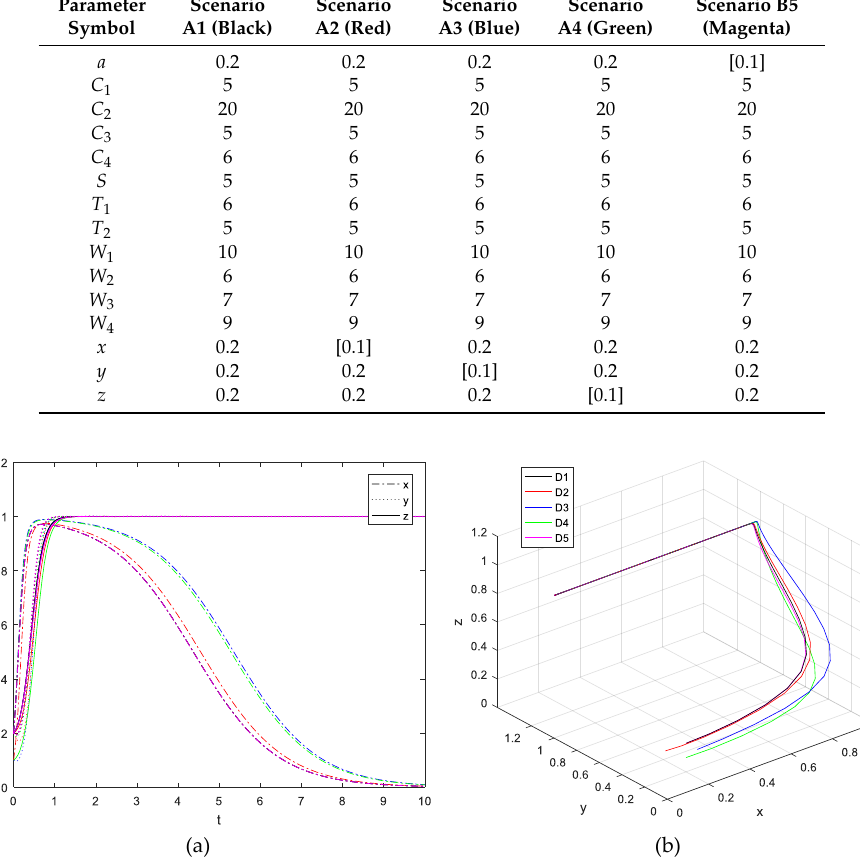
Figure 7. System evolution trend chart of ideal scenario. ( a ) Two-dimensional evolution diagram, ( b ) Three-dimensional evolution diagram.